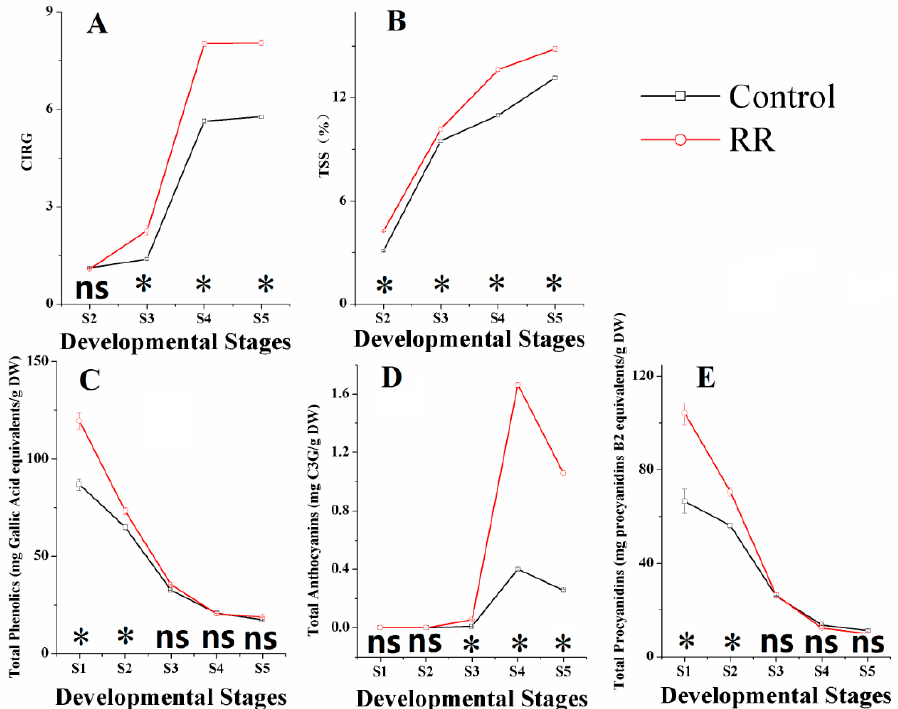
Figure 1. Effects of root restriction on berry parameters in different developmental stages. ( A ) chromatic aberration; ( B ) total soluble solids; ( C ) total phenolics; ( D ) total anthocyanins; ( E ) total procyanidins. S1, fruitlet; S2, immature green; S3, before veraison; S4, veraison; S5, fully ripe. * indicates significant differences ( p < 0.05), ns = not significant differences ( p > 0.05).